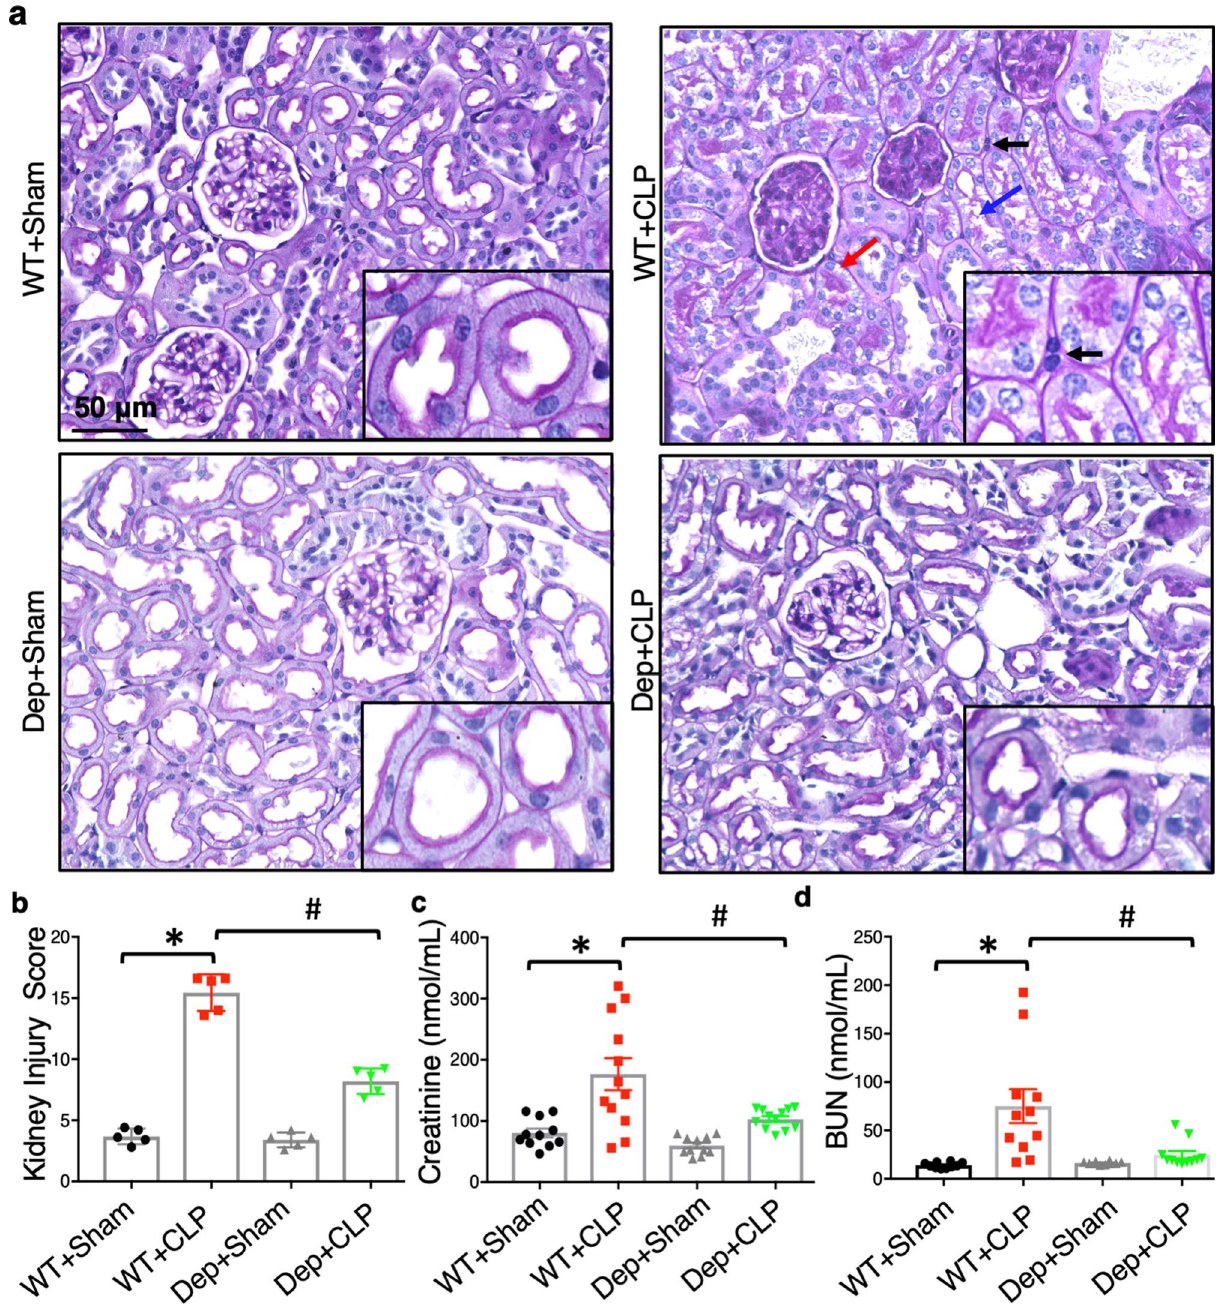
Figure 3. Zdhhc21 dep/dep mice are resistant to septic injury-induced kidney damage. ( a ) Representative images of Periodic Acid-Schiff-stained renal tissue collected 24 h after septic injury induction. Pathological alterations are indicated by arrows with different colors: brush border loss (blue), tubular cell detachment (red), neutrophil infiltration (black). Images are representative of 5 mice. ( b ) Mice with DHHC21 loss-of-function display a reduced renal injury score than WT mice after septic injury. n = 5 independent experiments; 5 views per animal were imaged and analyzed. ( c ) The level of circulating creatinine. Mouse plasma was collected 24 h after CLP-induced septic injury. n = 12. ( d ) The level of blood urea nitrogen 24 h after septic injury. n = 11. Results represent mean ± SEM. *p ≤ 0.05 versus WT + Sham, # p ≤ 0.05 versus WT +